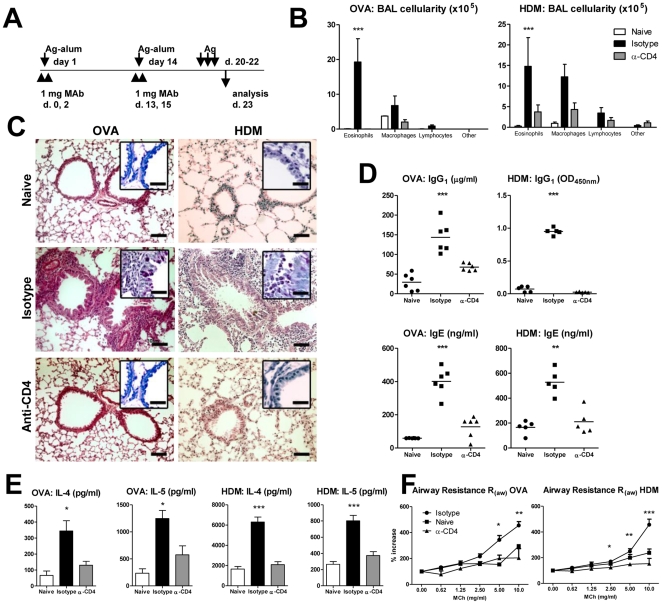
Prevention of allergic sensitization with anti-CD4 MAb.(A) Female BALB/c mice were sensitized with 20 µg OVA-alum or 50 µg HDM-Alum i.p. and challenged with 50 µg OVA or HDM in saline i.n. on the indicated days. Some animals were treated with 1 mg anti-CD4 or an isotype control i.p. as shown. Naive mice, not subjected to any intervention, were also studied as a control group. (B) Cellular composition of the BAL. Animals treated with anti-CD4 have less eosinophils in the BAL (n = 6, *** P<0.001). (C) Histological sections of lung tissue were stained with hematoxilin/eosin and PAS (inset). Anti-CD4-treated mice have reduced inflammatory infiltrate and goblet cell hyperplasia, to levels similar to naive controls. Bars represent 10 µm (2.5 µm in the inset). (D) Quantification of serum OVA- and HDM-specific IgG1 and IgE. Anti-CD4 MAb treated mice show a significant reduction of the Th2-driven immunoglobulins (n = 6, *** P<0.001 and ** P<0.01 as indicated). (E) The Th2 cytokines IL-4 and IL-5 were down to basal levels in lung homogenates of anti-CD4 treated mice (n = 6, * P<0.05 and *** P<0.001). (F) Invasive measurement of respiratory mechanics shows that animals treated with anti-CD4 MAbs had reduced airway resistance to increasing doses of inhaled MCh, when compared with sensitized control animals (n = 8). Data (B–F) are representative of at least three independent experiments.